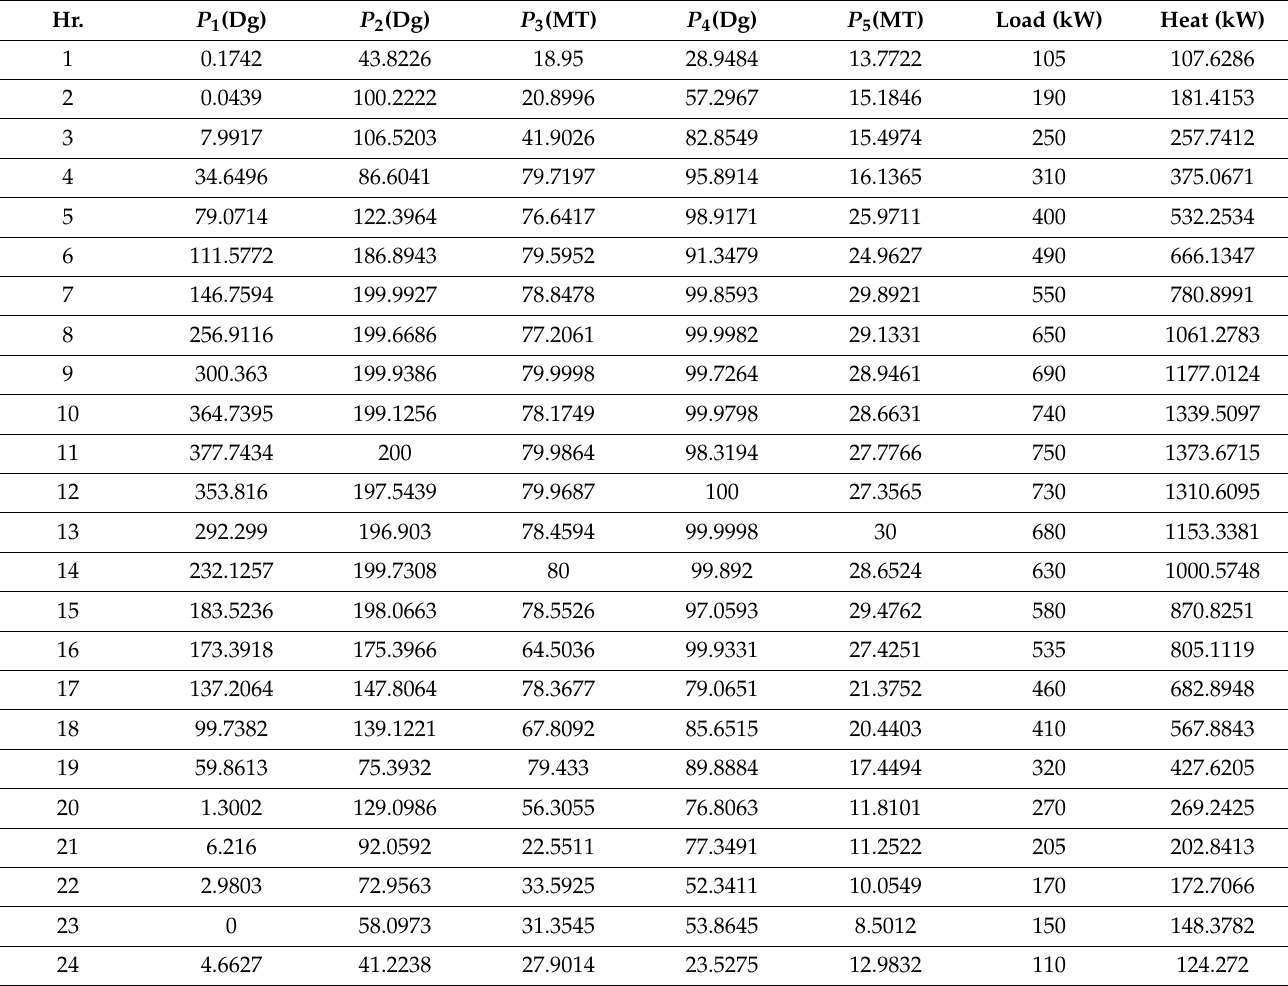
Table 9. Optimal generation scheduling for MCHPEED under